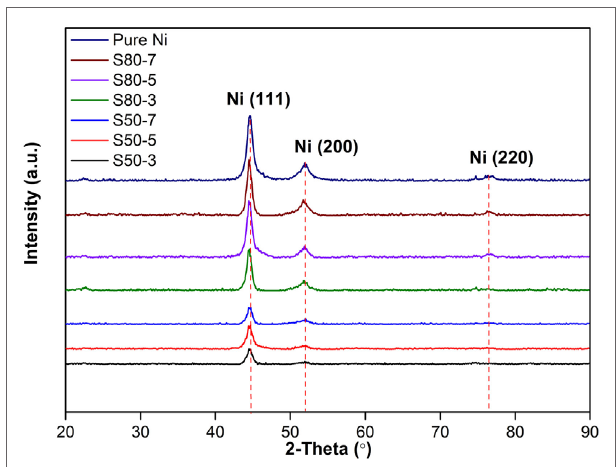
FigUre 1 | X-ray diffraction patterns of pure ni coatings and ni–TiO 2 nanocomposite coatings prepared at 3, 5, and 7 a dm − 2 current densities with 80 and 50 nm sized TiO 2 nanoparticles .